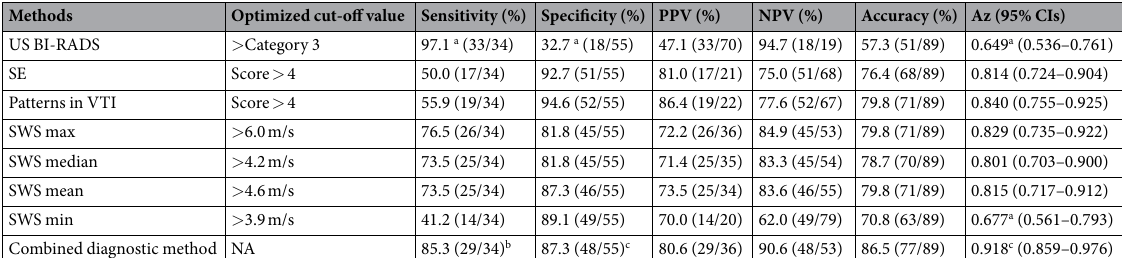
Table 4. The diagnostic performance of US BI-RADS, SE, VTI and VTIQ for malignancy prediction. US, ultrasound; BI-RADS, Breast Imaging Reporting and Data System; SE, strain elastography; VTI virtual touch tissue imaging; VTIQ virtual touch tissue imaging and quantification; SWS shear wave speed, PPV positive predictive value; NPV negative predictive value; Az, Area under the curve; CIs confidence intervals. a p < 0.05 in comparison with SE, VTI, SWS max, SWS median and SWS mean. b p = 0.075 in comparison with BIRADS. c p < 0.05 in comparison with